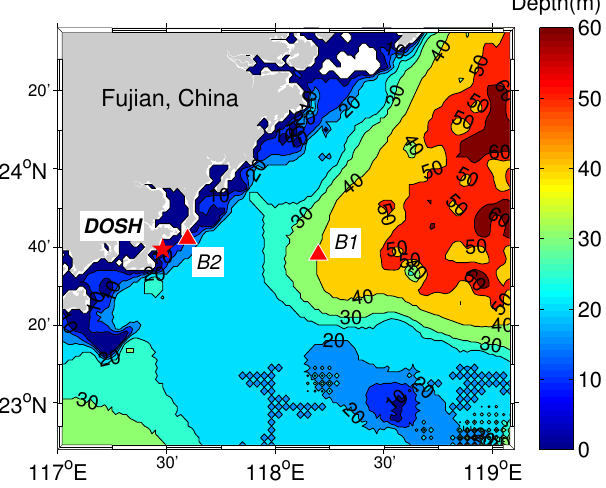
Figure 6. Map of the experiment site over the Taiwan strait. The water depth is depicted in the form of filled bathymetric contour. The HF radar was deployed at the site of DOSH marked by red pentagram. There were two buoys marked as B1 and B2 with red triangles, which are, respectively, 73 km and 12.7 km away from the radar in the direction of 91.8 ◦ and 66.6 ◦ with respect to the